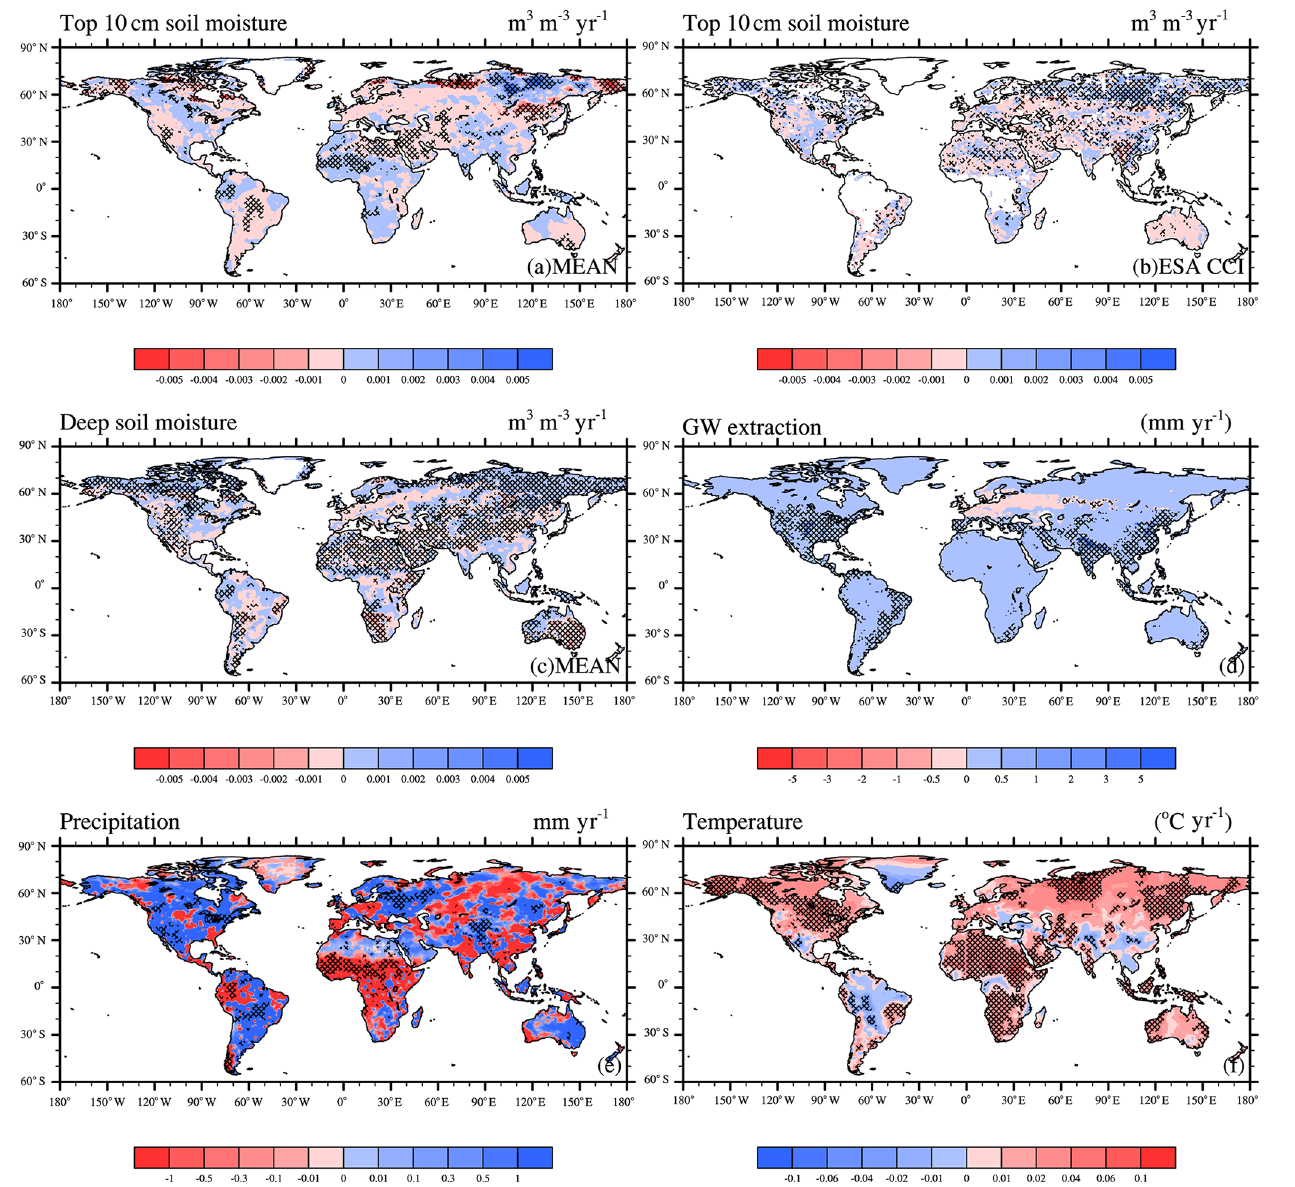
Figure 6. The spatial distribution of linear trends for (a) simulated surface soil moisture (m 3 m − 3 yr − 1 ) and (b) surface soil moisture from ESA-CCI (m 3 m − 3 yr − 1 ), (c) simulated deep soil moisture (m 3 m − 3 yr − 1 ), (d) groundwater extraction (mmyr − 1 ), (e) precipitation (mmyr − 1 ), and (f) temperature ( ◦ Cyr − 1 ). The shaded areas represent grids with statistically significant trends ( p < 0 .